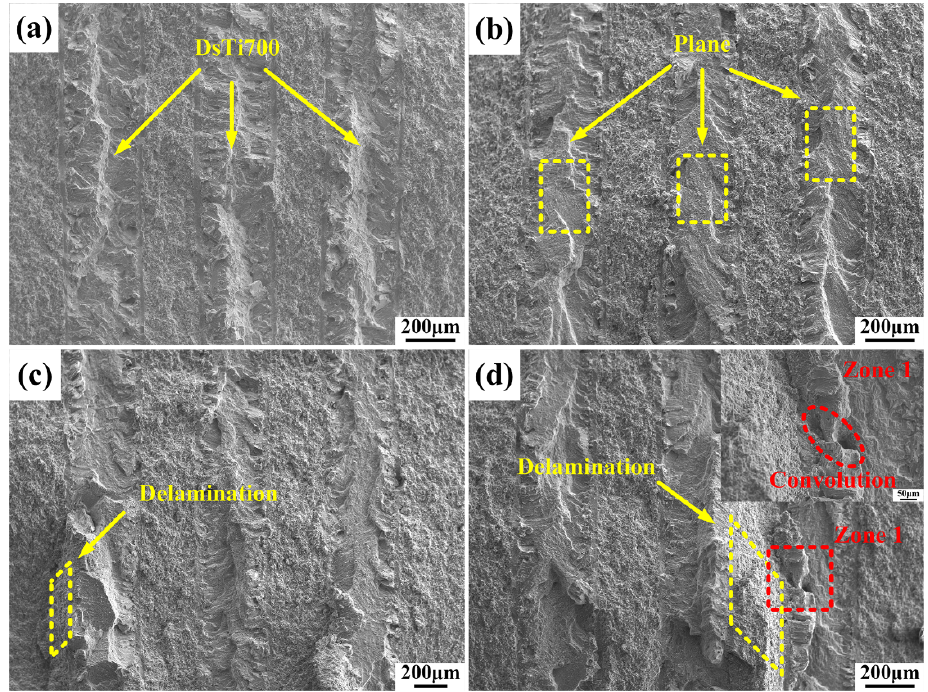
Figure 11. Fracture morphology of the initial and heat-treated composites tested in divider orienta- tion: ( a ) initial composite, ( b ) HT1, ( c ) HT3 and ( d ) HT5.